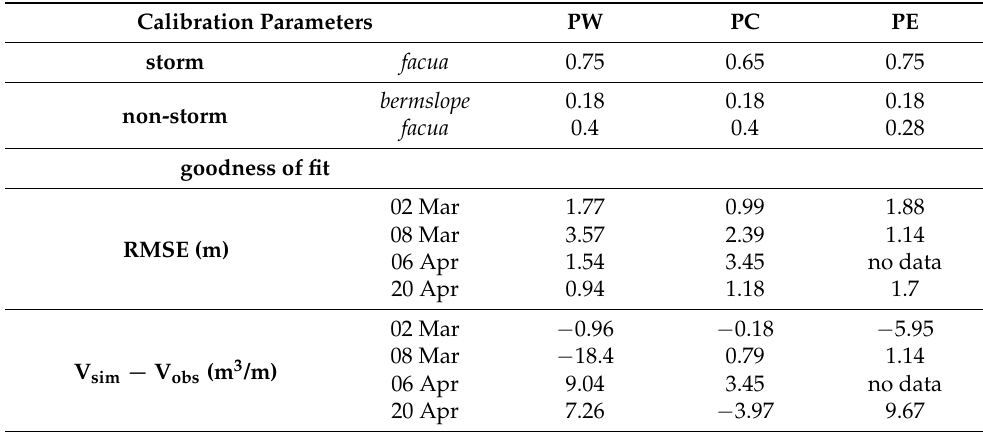
Table 3. Calibration parameters (storms correspond to H s ≥ 3 m) and related goodness of fit indicators for the 3 profiles (PW, PC and